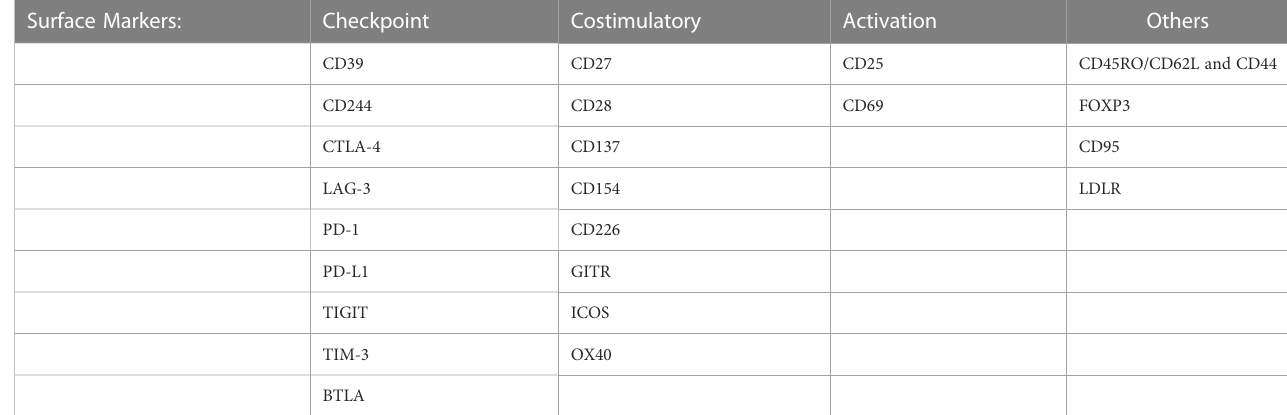
TABLE 1 Summary of all surface markers analyzed on CD4 + and CD8 + T cells after stimulation for 48 h and 96 h. Surface Markers: